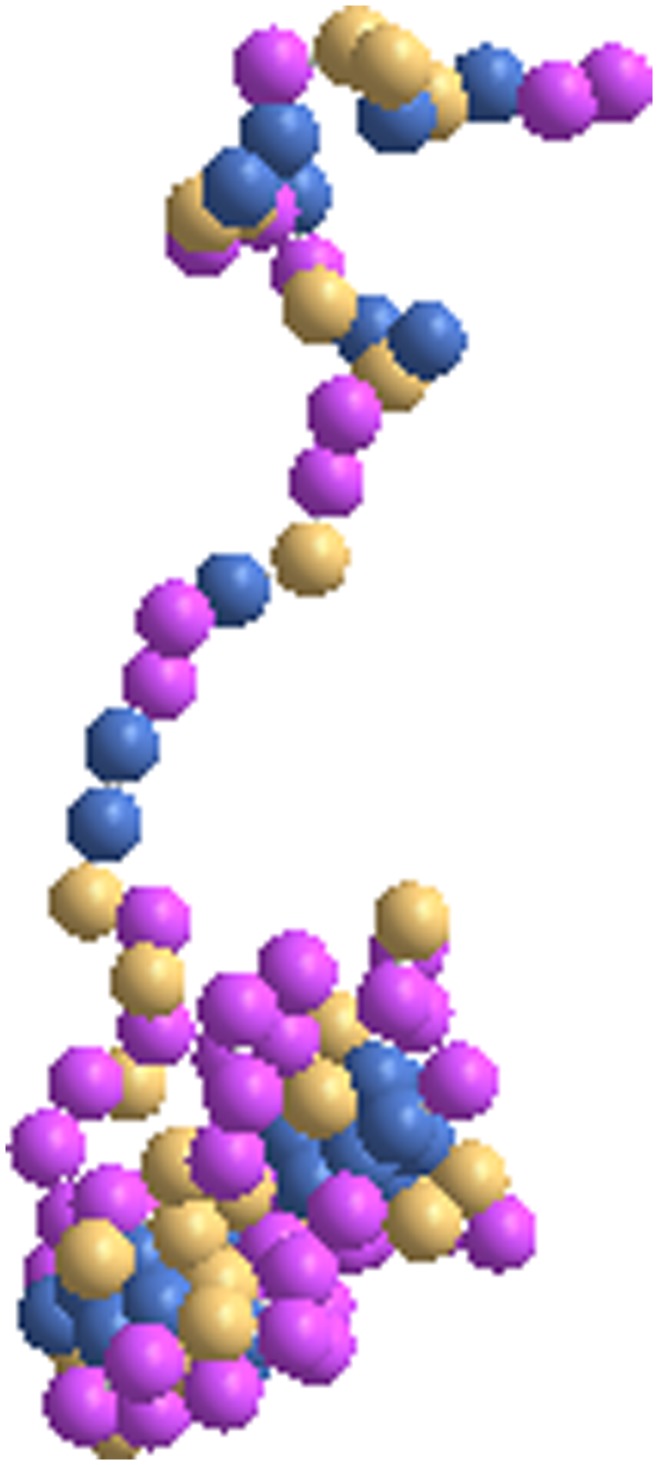
Snapshots of the histone H3.1 at t = 107 time step at the temperatures T = 0.016 using MJ potential2.